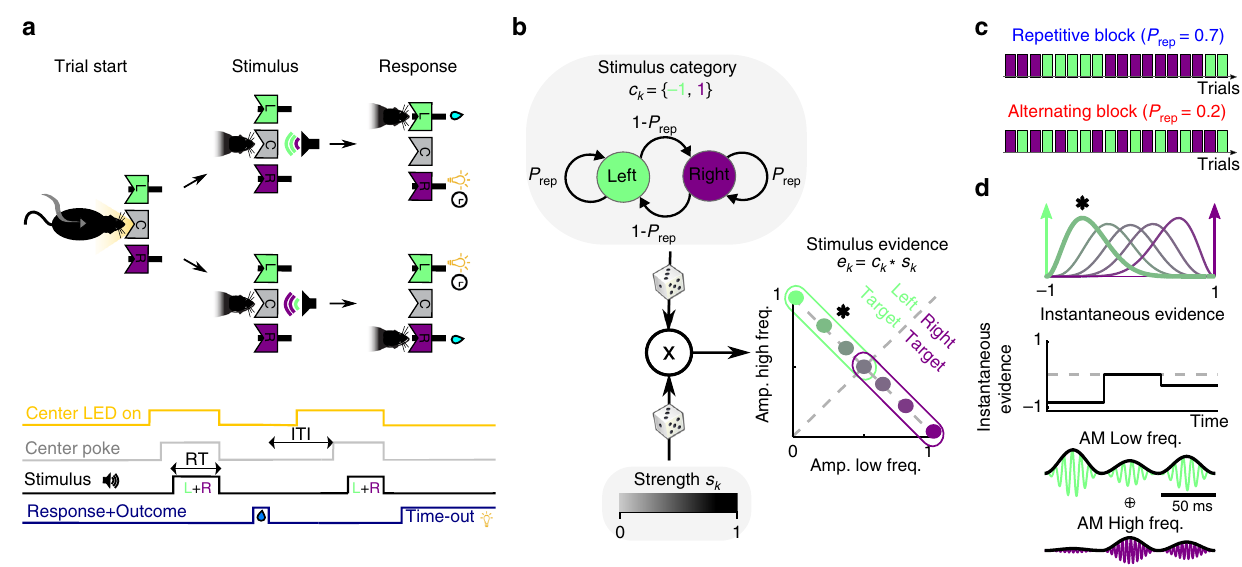
Fig. 1 Auditory discrimination task and stimulus sequence statistics. a Sketch of one trial of the task: cued by center port LED, rats poke in the center port to trigger the presentation of a mixture of two AM tones, each of which is associated with reward in the left (L) or right (R) port. Correct responses are rewarded with water, and incorrect responses are punished with a light plus a 5-s timeout. RT, reaction time. b , c Serial correlations in the sequence of stimuli were introduced by setting the probability of repeating the previous stimulus category P rep (top in b ) in blocks of 200 trials named repetitive block and alternating block ( c ). The stimulus strength s k was randomly drawn in the kth trial (bottom in b ) to yield the stimulus evidence e k , that determined the distance to the categorization boundary, i.e., the discrimination dif fi culty of the stimulus (right in b ). d The stimulus evidence e k determined the distribution (top) from which the instantaneous evidence was drawn in each frame of the sound envelope (see color match with b ). An instantaneous evidence trace (middle) and the AM modulated tones that result (bottom) are shown for an example stimulus with e = − 0.48 (asterisks in b and d